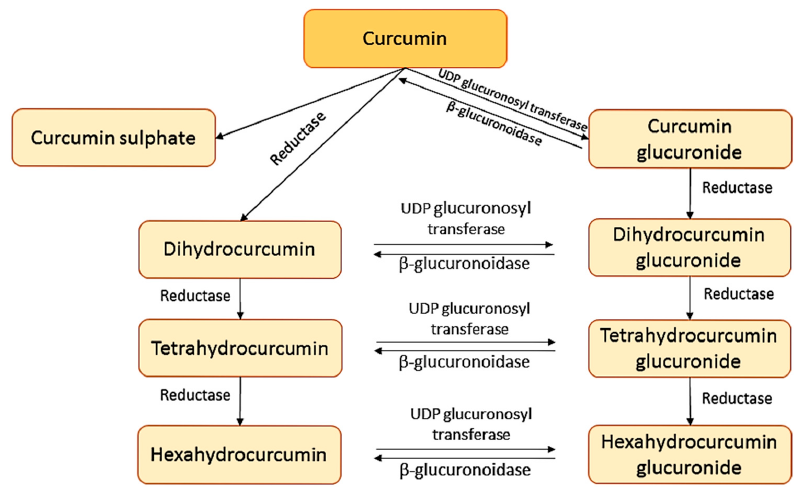
Figure 2. Metabolite derivatives of curcumin.